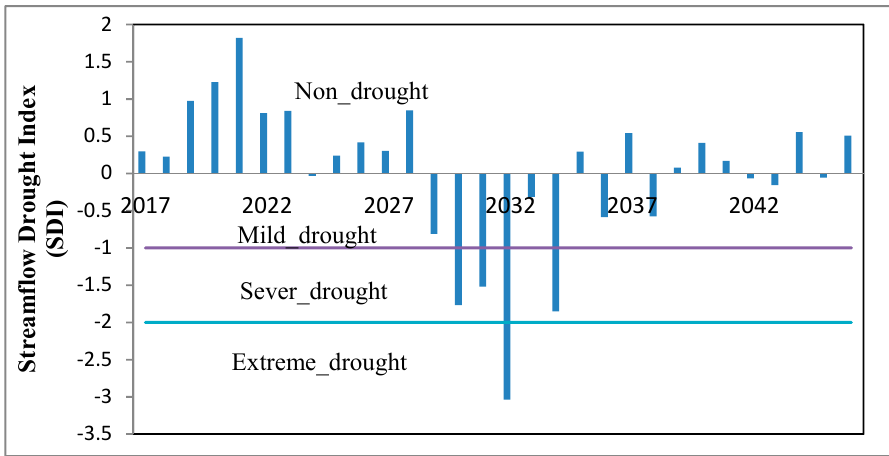
Figure 3. Stream flow Drought Index for period of studied years.